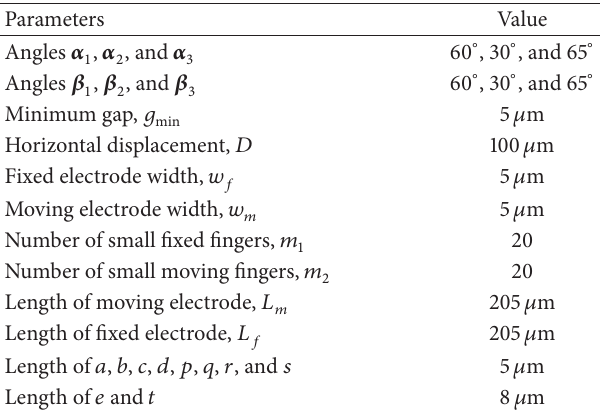
Table 1: Parameters of basic fishbone shaped comb